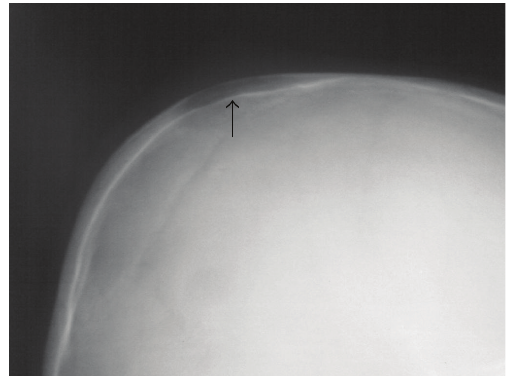
Figure 2: Plain radiograph of the skull taken at time of presentation showing a lytic lesion on the left frontoparietal bone.